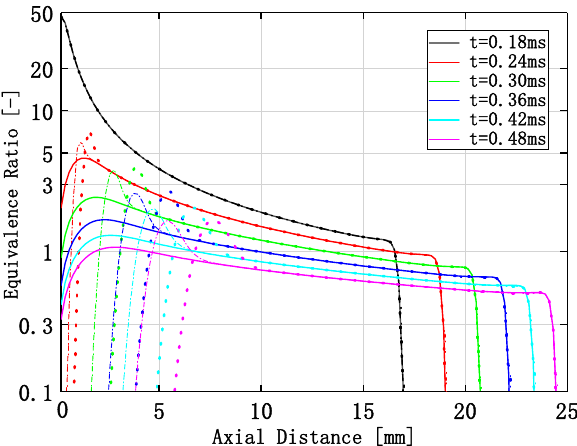
Figure 14. Equivalence ratio of the ramping-down injection with gas-jet and the ramping-down injection without gas-jet (solid lines: ramping-down injection without gas-jet; chain lines: ramping-down injection with gas-jet of 100 m/s; dotted lines: ramping-down injection with gas-jet of 200 m/s).